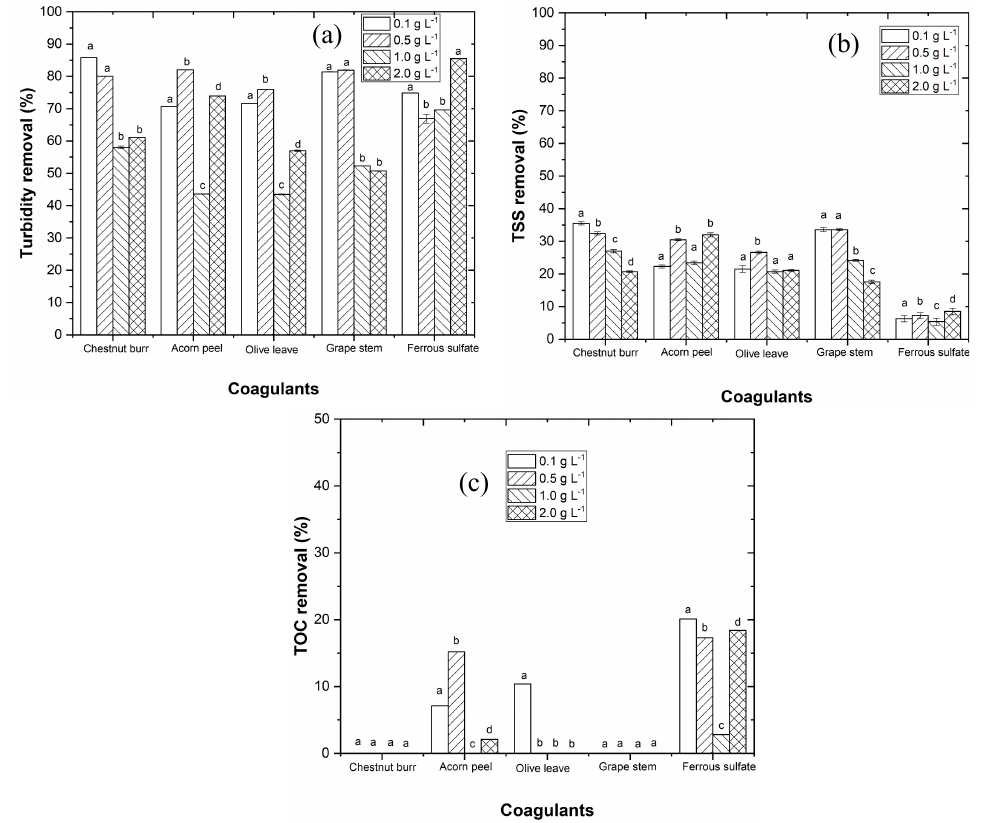
Figure 6. Progress of ( a ) turbidity, ( b ) TSS and ( c ) TOC removal along the CFD process, testing different coagulant dosage (0.1, 0.5, 1.0, 2.0 g L − 1 ). Experiment conditions: pH = 3 (for plant-based coagulants), pH = 5 (for ferrous sulfate), T = 25 °C, fast mix 150 rpm for 3 min, slow mix 20 rpm for 20 min, sedimentation time of 12 h ([TOC] 0 = 144 mg C L − 1 , turbidity 0 = 16 NTU, TSS 0 = 64 mg L − 1 . Different letters between the graphic bars mean that values are statistically different ( p < 0.05).